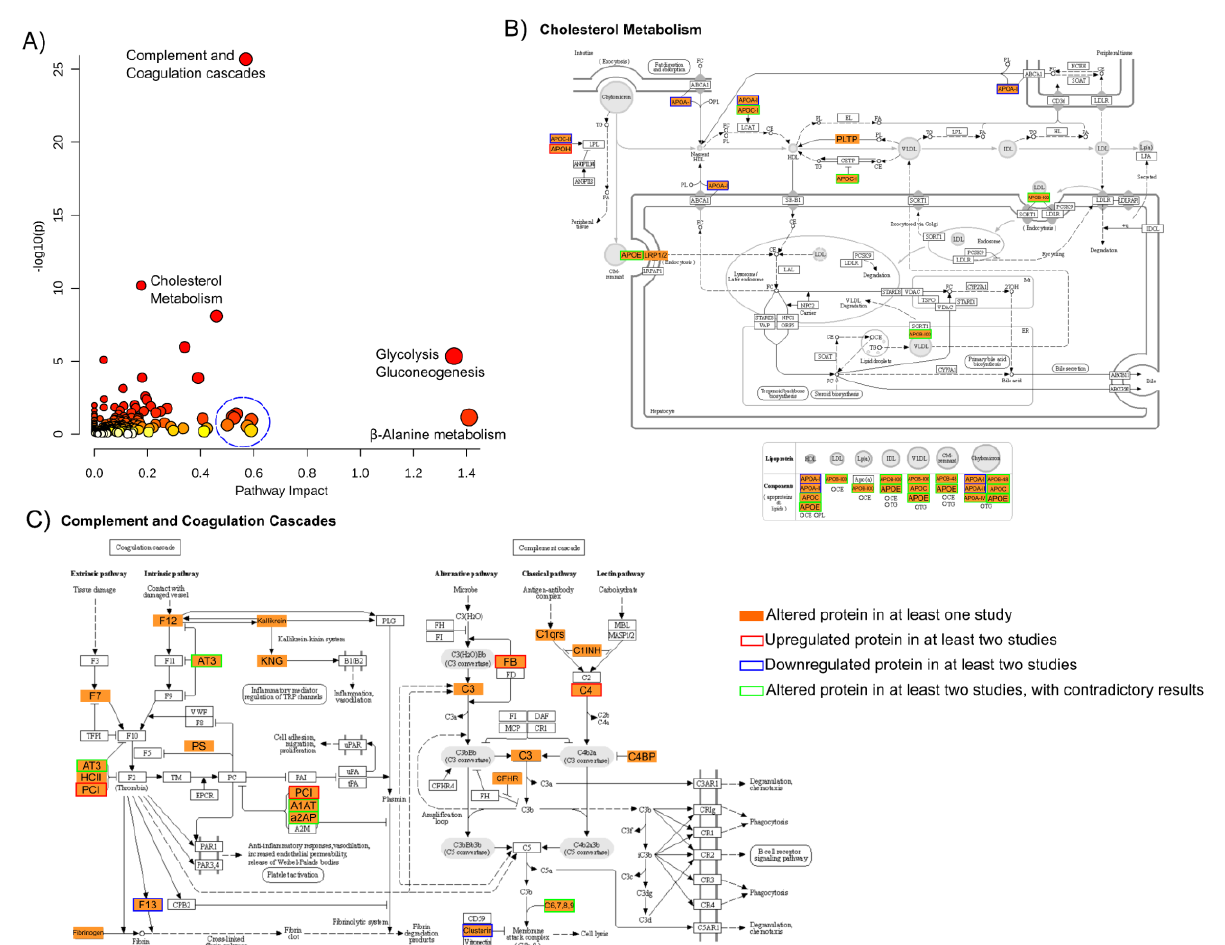
Figure 6. Gene ontology analysis of all proteins considered altered throughout the analyzed reports. A gene ontology approach was used to assess pathway impact and enrichment (here presented by the p -value and color scheme in ( A )) of all proteins described as altered between controls and SCZ in at least one study (Supplementary Information, Table S2), represented here as a scatter plot [60] . The blue circle highlights a cluster of ontologies, all belonging to metabolic pathways. From the pathways shown as enriched by this list of proteins, two were selected and their visual representation was obtained through the KEGG Mapper Color tool [61,62] : ( B ) cholesterol metabolism and ( C ) complement and coagulation cascades. In these KEGG panels, the proteins found in any of the studies are shown in orange, and proteins found to be altered in at least two studies are highlighted in red or blue when the protein is always found to be up- or down-regulated in SCZ cases (respectively) or highlighted in green when the results from the two or more studies are contradictory.